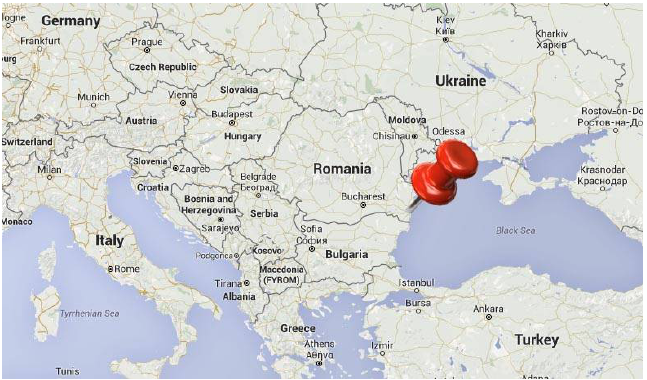
Figure 1. Location of Constanta City in Europe. Source: Google map processed image